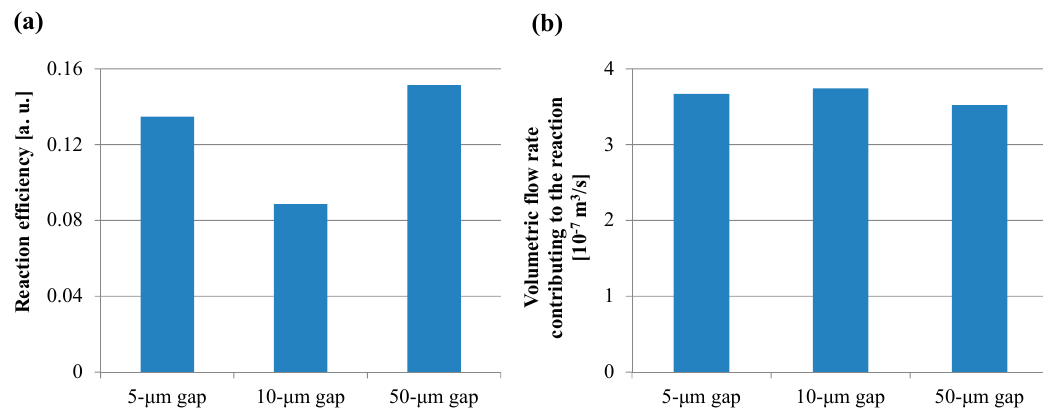
Figure 12. ( a ) Reaction efficiency calculated using Equation (15). ( b ) Volumetric flow rate calculated using Equation (16).